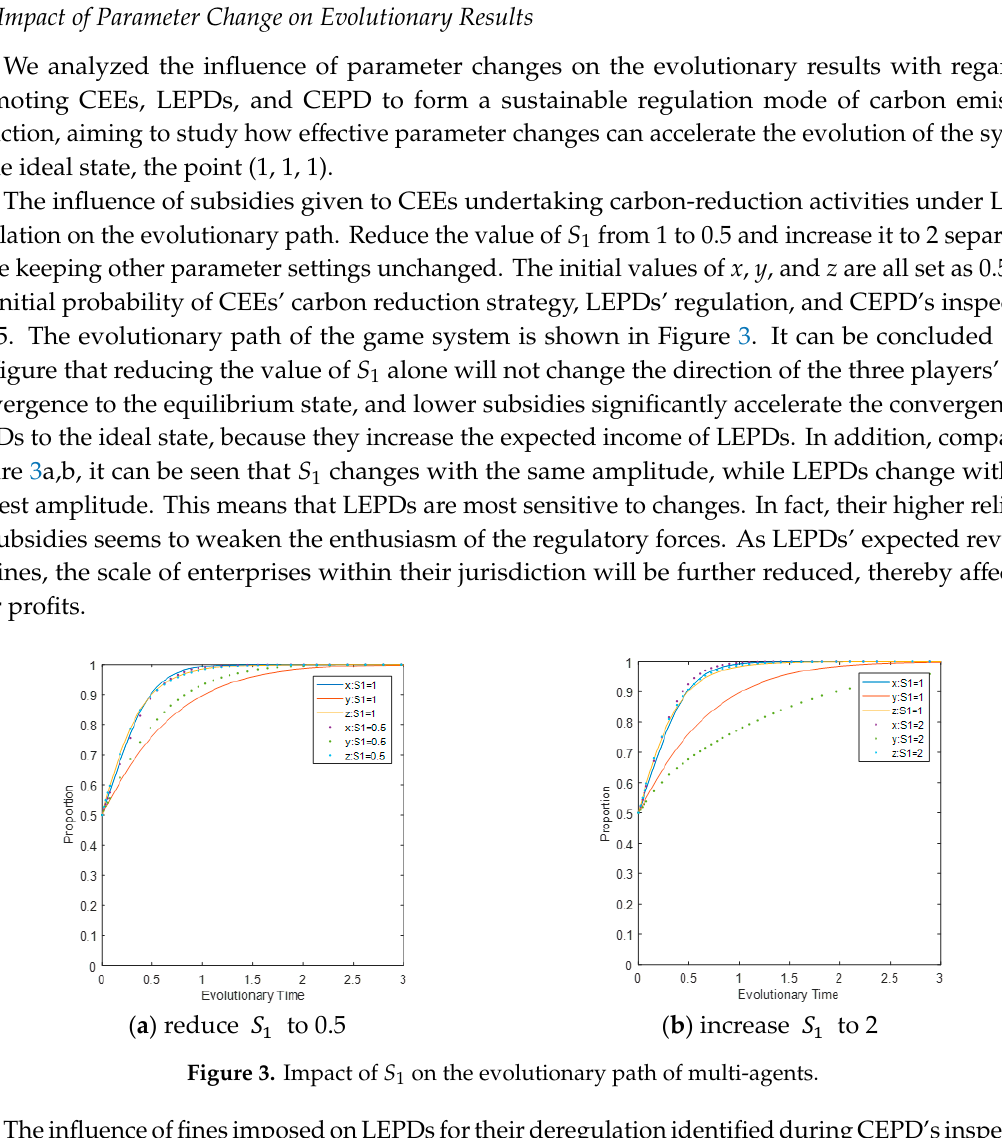
Figure 2. Impact of initial strategy on evolutionary results.